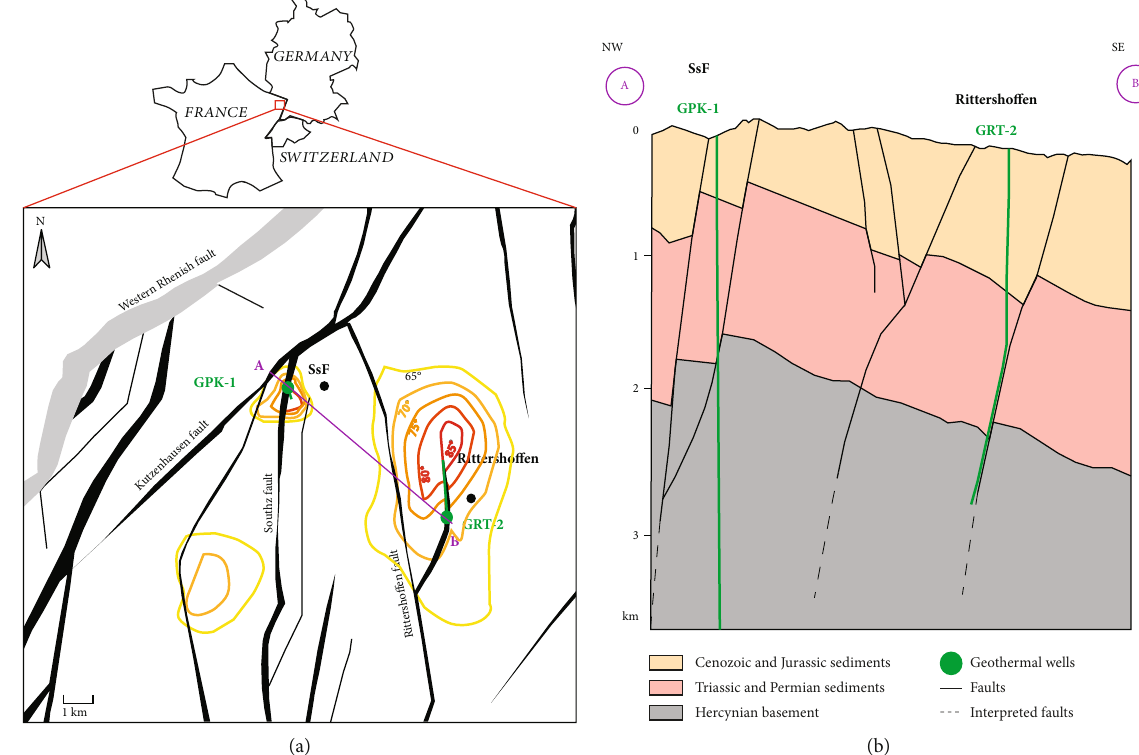
Figure 2: (a) Structural map of the top of the granitic basement from the GeOrg geoportal with the well trajectories (green), the thermal anomalies [3], and the Soultz (SsF) and Rittersho ff en localizations. (b) Geological cross section through the GPK-1 and GRT-2 wells crossing the URG sedimentary cover and granitic basement; the well trajectory of the GRT-2 well is a NW-SE projection on the cross section, from the last 3D seismic campaign